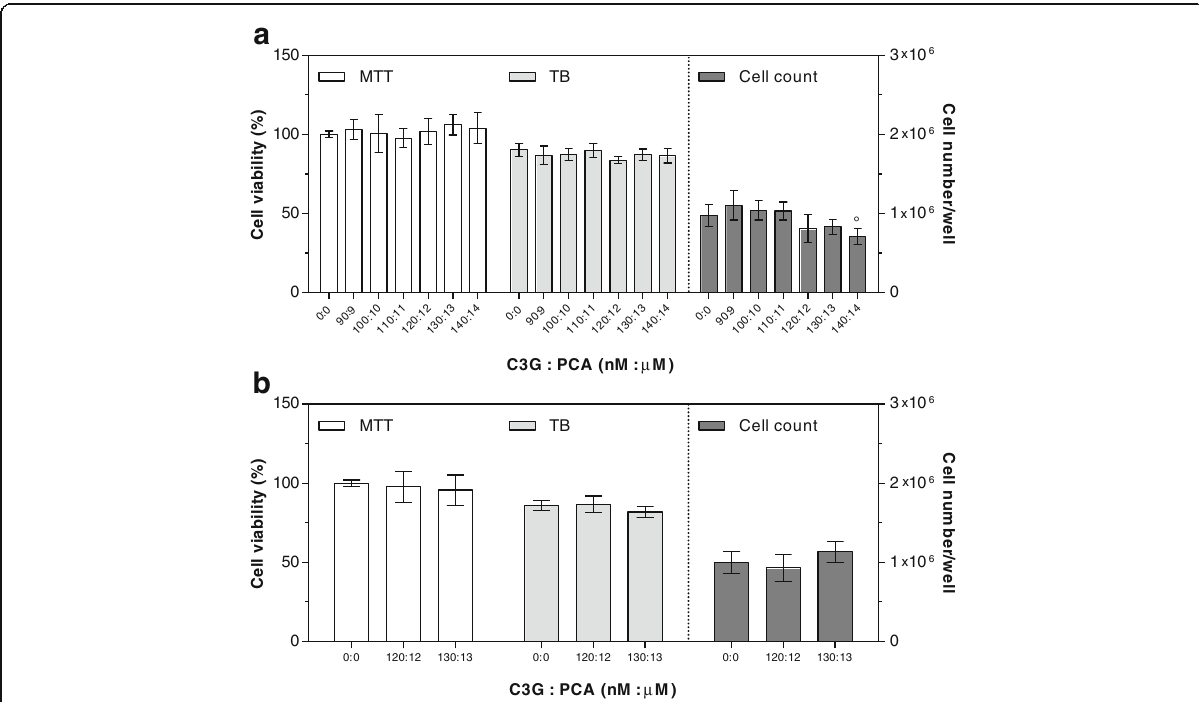
Fig. 5 Cytotoxic effects of C3G plus PCA after 24 ( a ) and 48 ( b ) hours of supplementation. Cell viability by MTT is expressed as percentage of control cells (assigned as 100%). TB is expressed as percentage of total cells. Cell count is expressed as number of cells per well. Data are means ± SD of six samples obtained from two independent experiments. Statistical analysis was by the one-way ANOVA (panel a : cell count p < 0.01, MTT and TB, n.s.; panel b : MTT, TB, and cell count n.s.) using Dunnett ’ s as post-test to compare supplemented cells to control ones (° p <